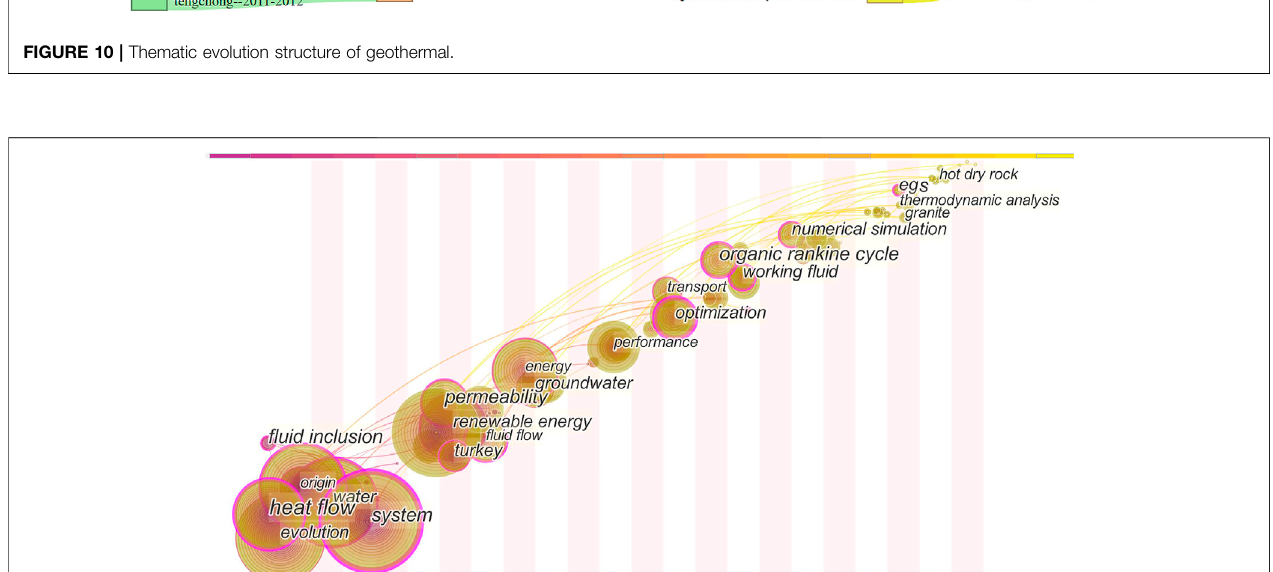
FIGURE 11 | Timezone view of